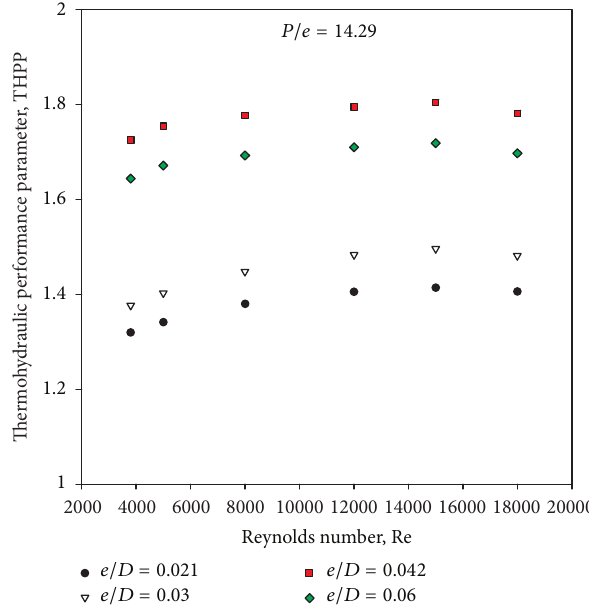
Figure 12: Variation of thermohydraulic performance parameters with Reynolds number.